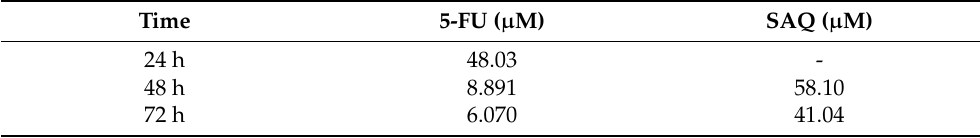
Table 3. Values of IC 50 were obtained after exposure of A549 cells to 5-FU and SAQ for various time points.